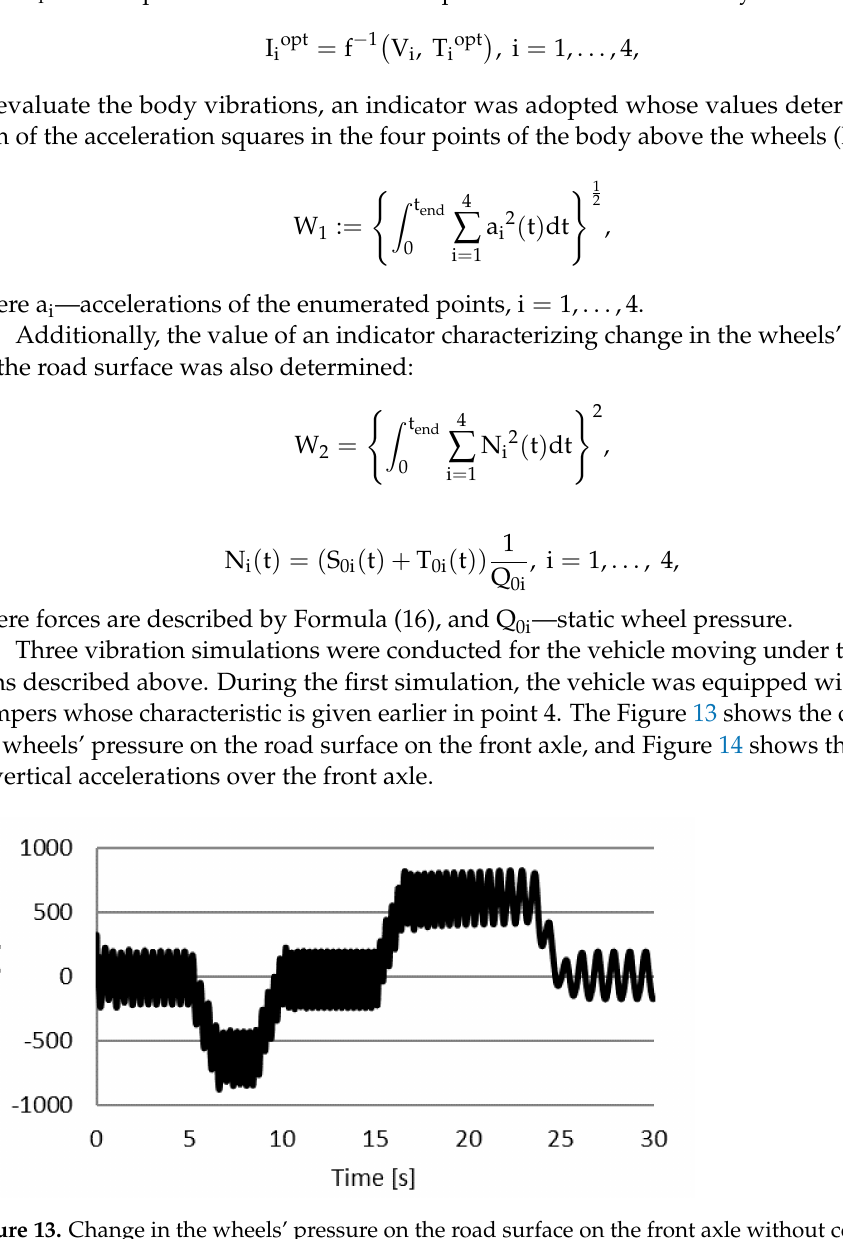
Figure 13. Change in the wheels’ pressure on the road surface on the front axle without